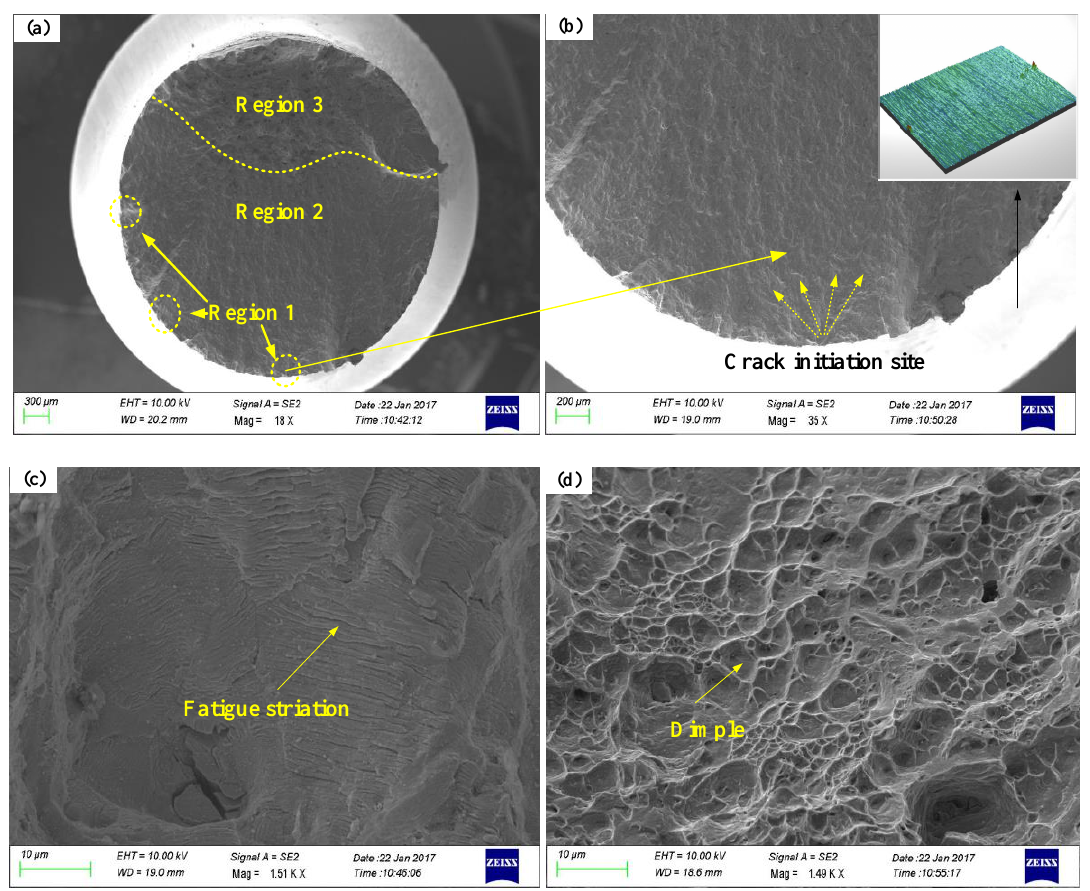
Figure 11. Fracture surface of TCP specimen ( R a = 0.024 µm): ( a ) overview of fracture surface; ( b ) Crack nucleation site; ( c ) fatigue striations and ( d ) dimples.